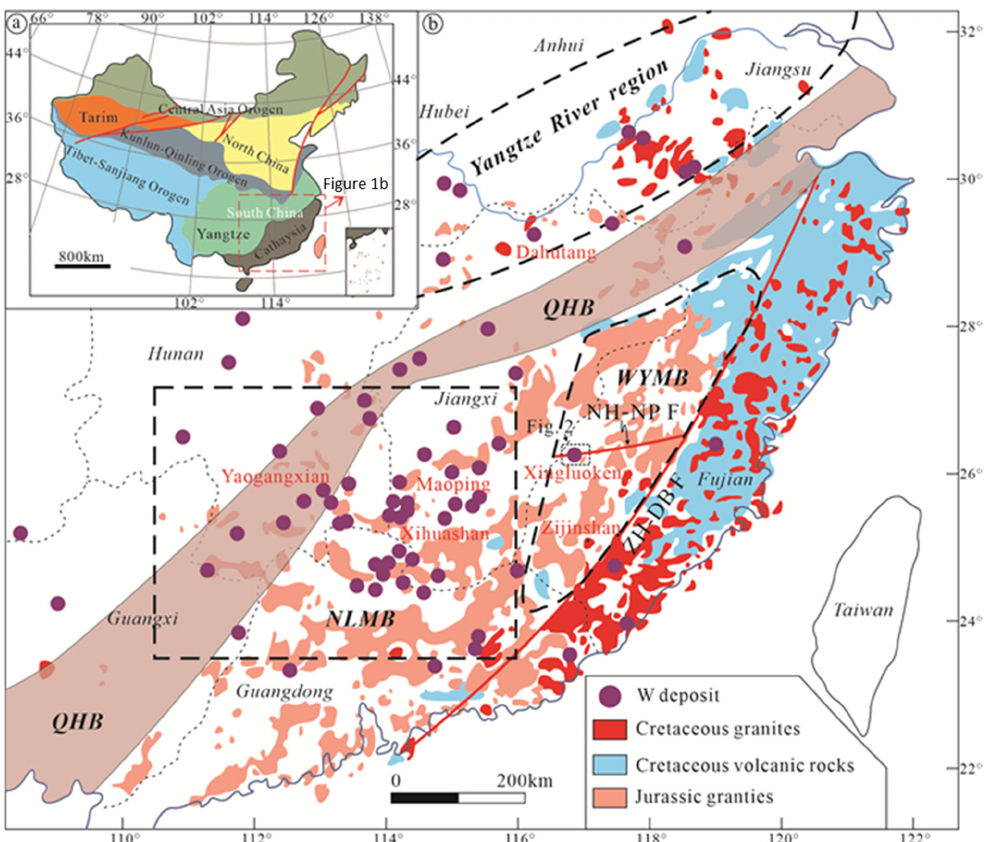
Figure 1. ( a ) Tectonic map of China. ( b ) Geologic map showing the distribution of Mesozoic granitoids and major tungsten deposits in south China (modified after [14–16]). NLMB = Nanling metallogenic belt, QHB = Qin-Hang metallogenic belt, WYB = Wuyi metallogenic belt, ZH-DB F = Zhenghe-Dabu fault, NH-NP F = Ninghua-Nanping fault. Due to the distinct 3 He/ 4 He ratios of the crust (~0.05–0.01 Ra, where Ra is the atmos- pheric 3 He/ 4 He ratio, 1.39 × 10 − 6 ) and upper mantle (6–9 Ra), and different 40 Ar/ 36 Ar ratio